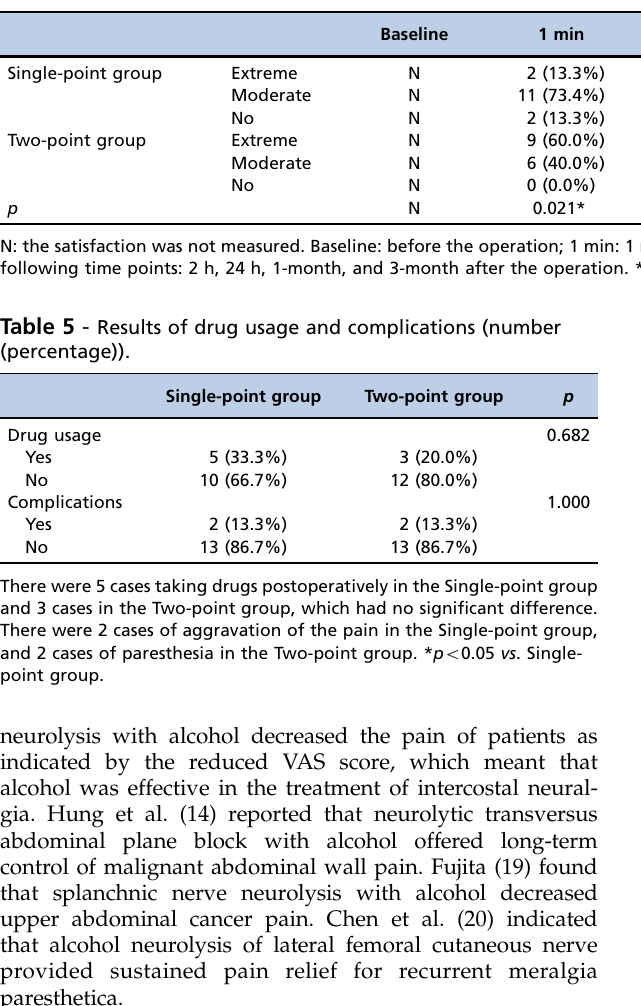
Table 4 - The satisfaction of patients (number (percentage)).